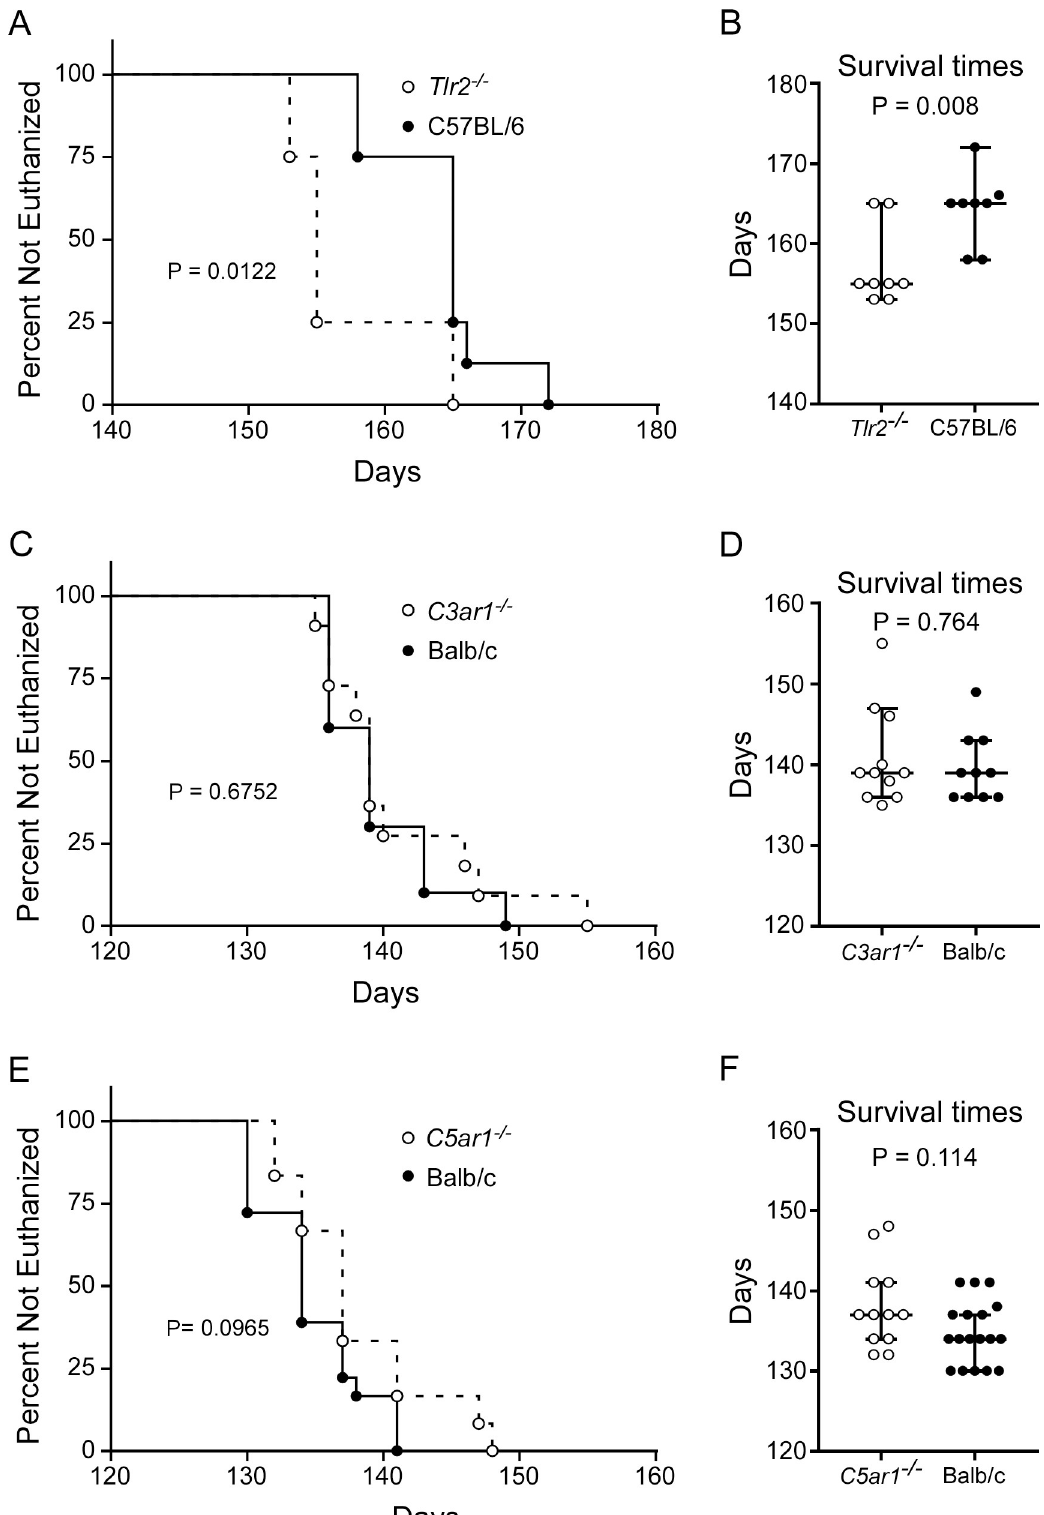
Fig 2. Survival of Tlr2 -/- , C3ar1 -/- , and C5ar1 -/- mice relative to control mice infected with scrapie strain 22L. Survival curves comparing 22L-infected control mice (filled circles) to mice deficient in Tlr2 (A and B, open circles), C3ar1 (C and D,